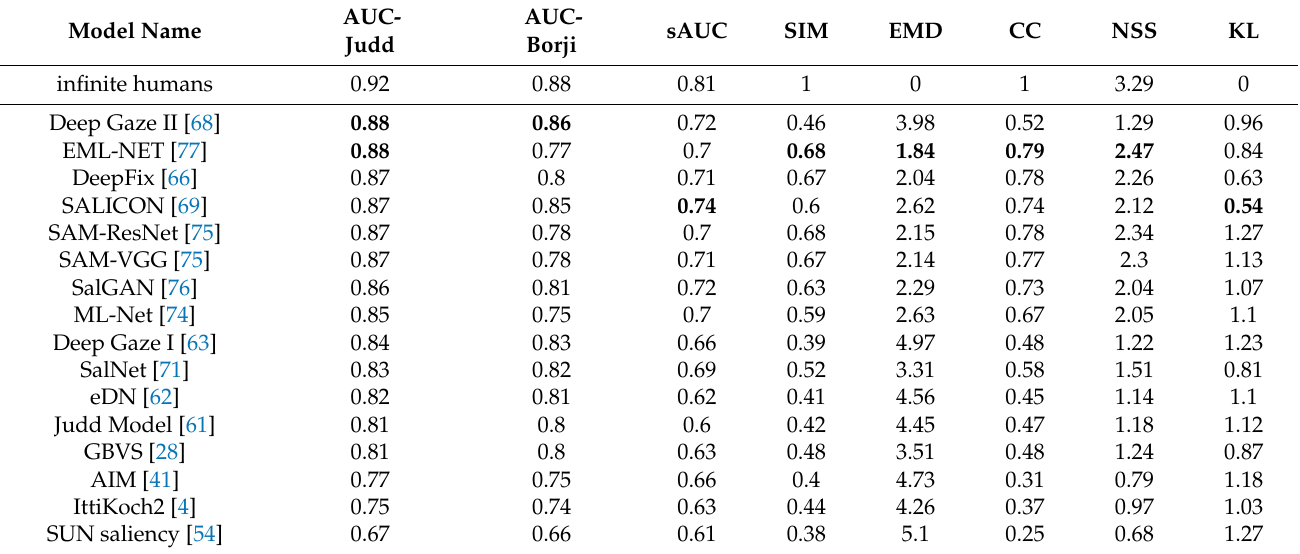
Table 2. Performance of the static models over the MIT300